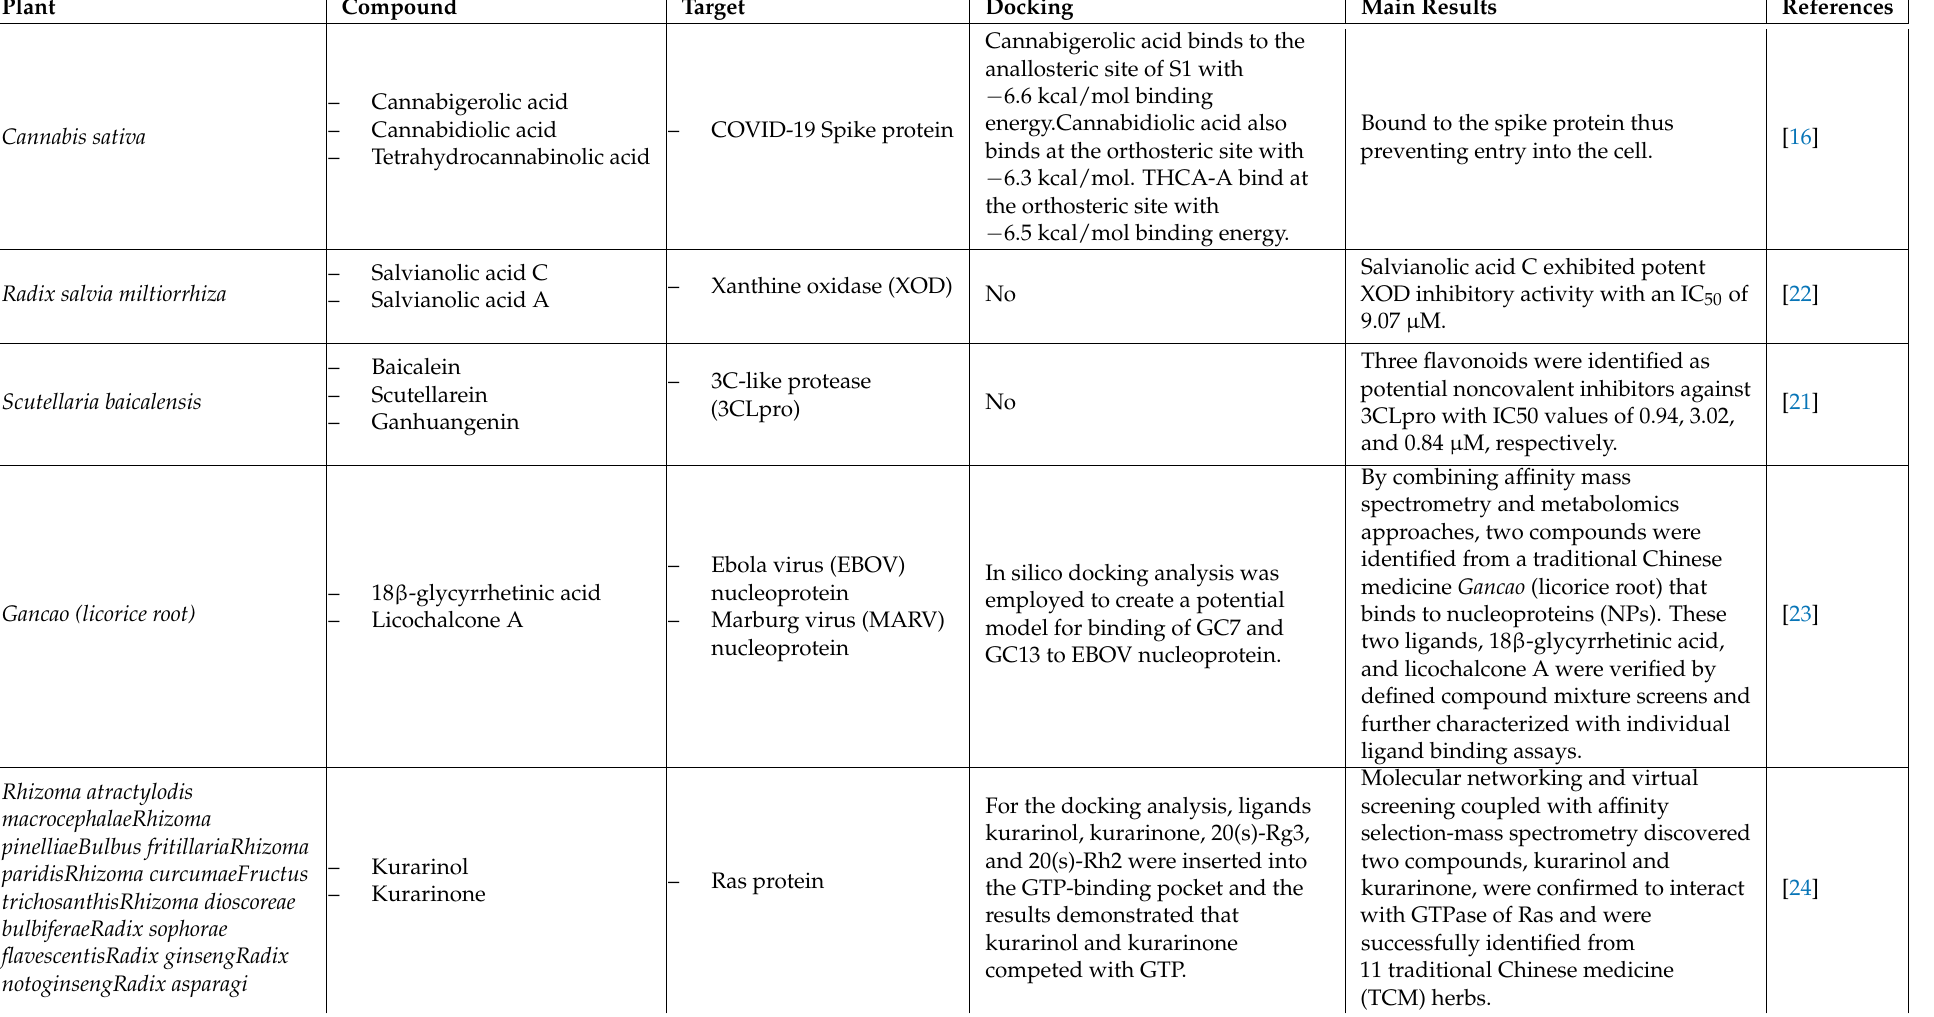
Table 2. Identification of plant-derived bioactive compounds using